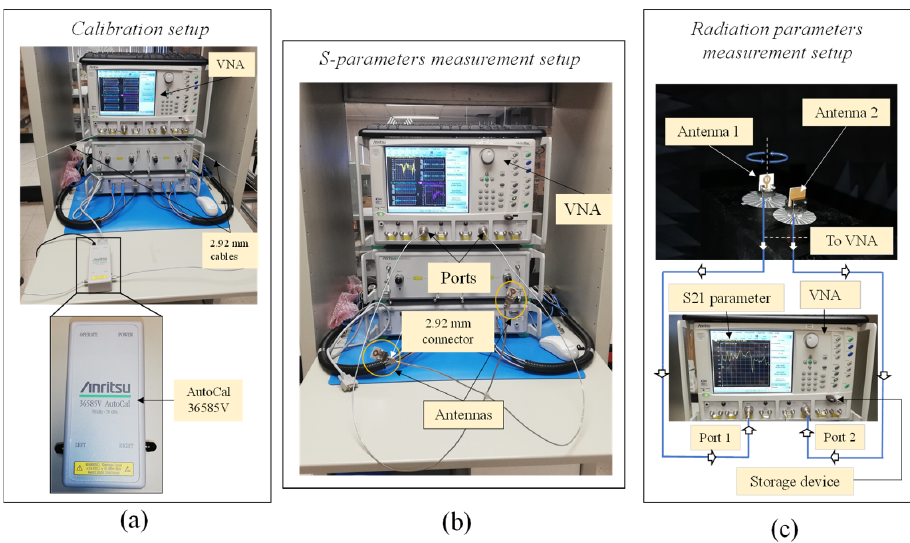
(VNA), in conjunction with an automatic calibration device (Autocal 36585 V). Figure 9 shows the experimental setup.